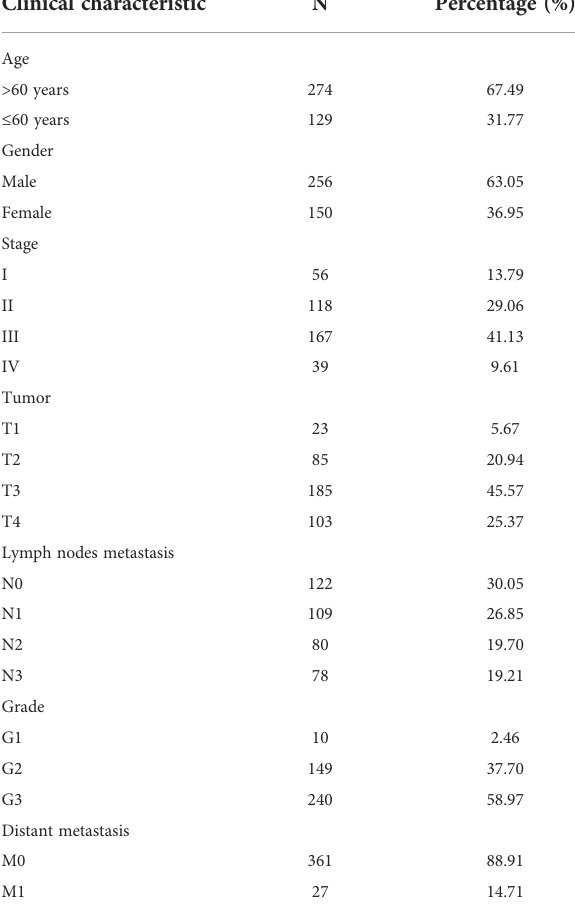
TABLE 1 Clinicopathological characteristics of 406 STAD patients obtained from the TCGA database. Clinical